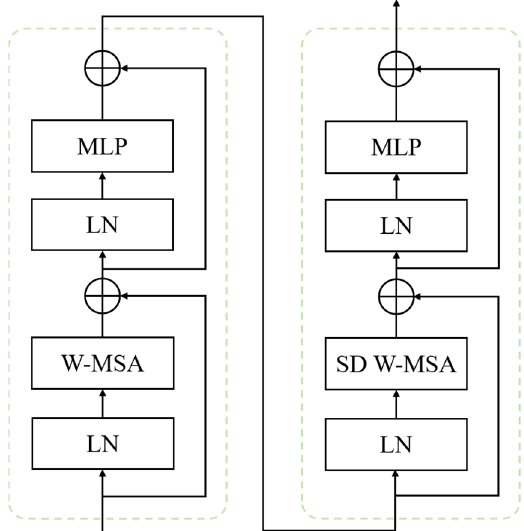
Figure 5. Two successive swin transformer blocks in encoder. W-MSA and SD W-MSA are Window-based Multi-head Self-Attention and Window-based Multi-head Self Attention with spatial displacement, respectively.